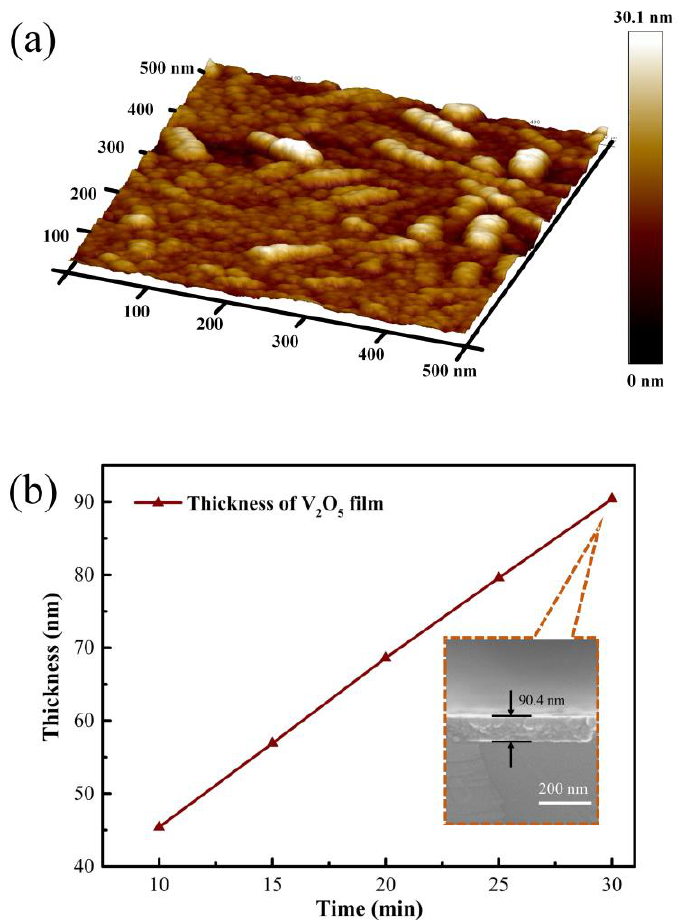
Figure 1. Three-dimensional morphology of V 2 O 5 thin film on R-plane sapphire substrate ( a ), the synthesized V 2 O 5 film with different thickness and SEM cross section image ( b ).